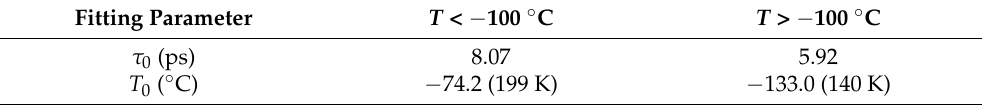
Table 2. Fitting parameters for the relaxation time estimated by using Equation